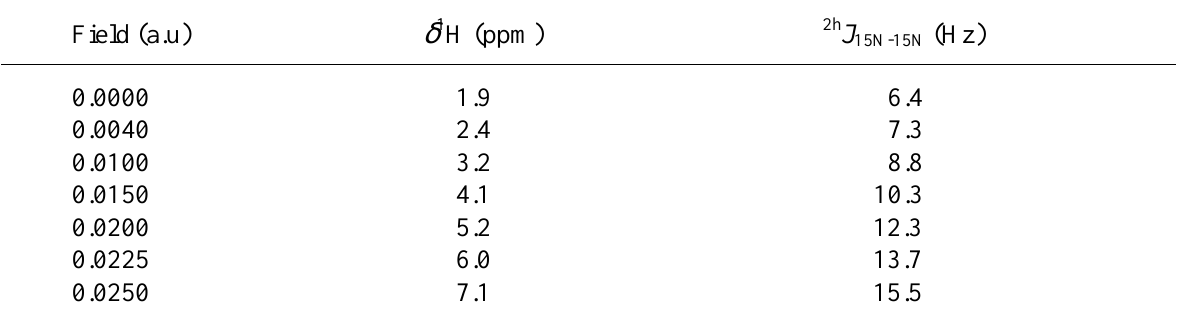
Table 6 . Chemical shifts of the hydrogen-bonded proton and 2h J of field